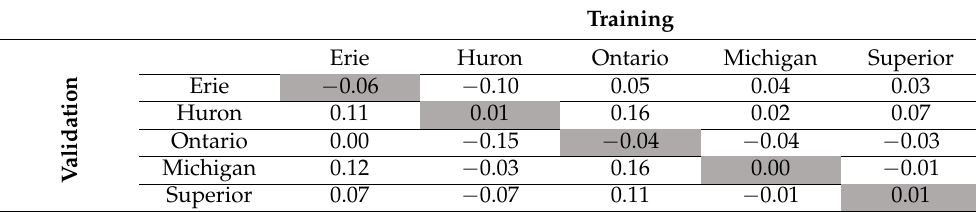
Table 5. Summary statistics of the bias on the estimation of water surface elevations using a random forest model trained using I , C , and W variables over a lake and applied to the remaining four. The diagonal line represents the results of the 5-fold cross-validation.